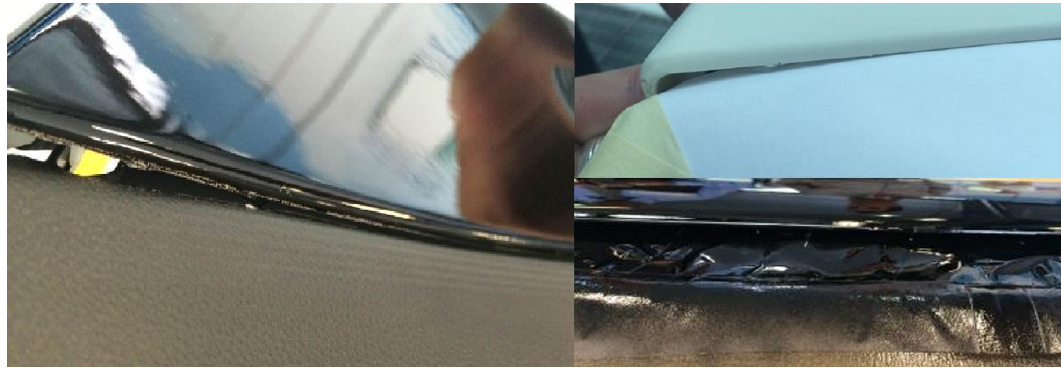
Figure 24. Painting process using paper for masking.